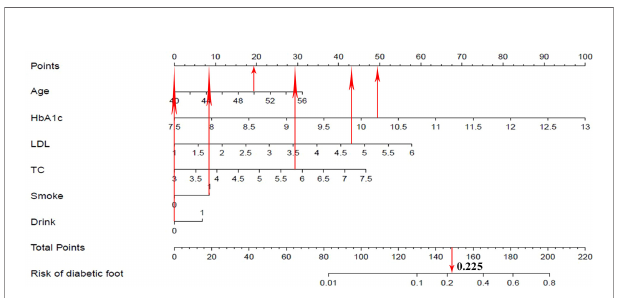
FIGURE 6 | Visualization application of the nomogram prediction for the risk of diabetic foot in patients